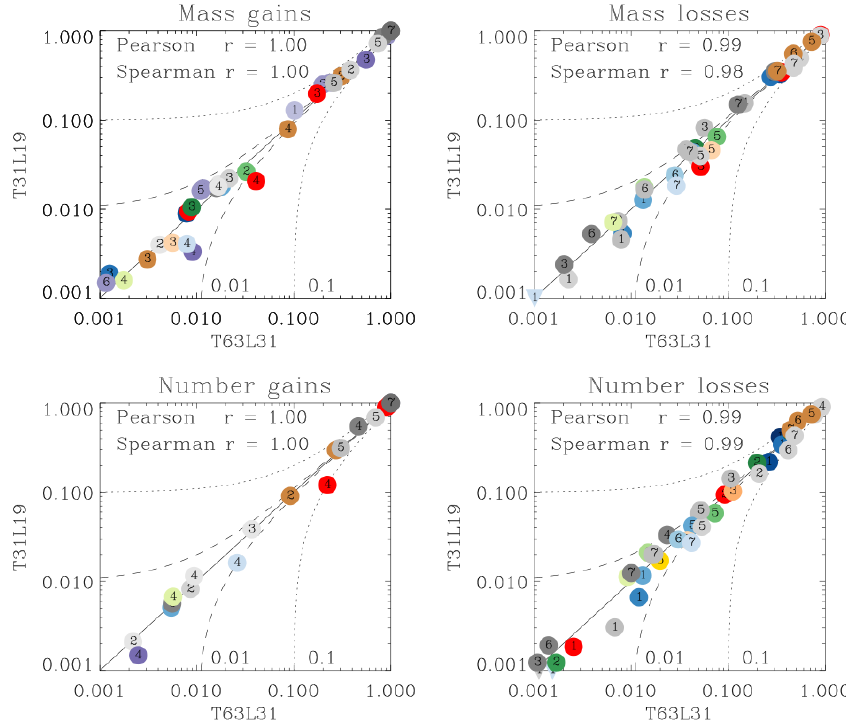
Figure 24. Fractional tendencies for the T31L19 low-resolution experiment versus the baseline T63L31 high-resolution experiment. Colors indicate processes (Table 2), numbers indicate modes (Table 3). Results are shown for North